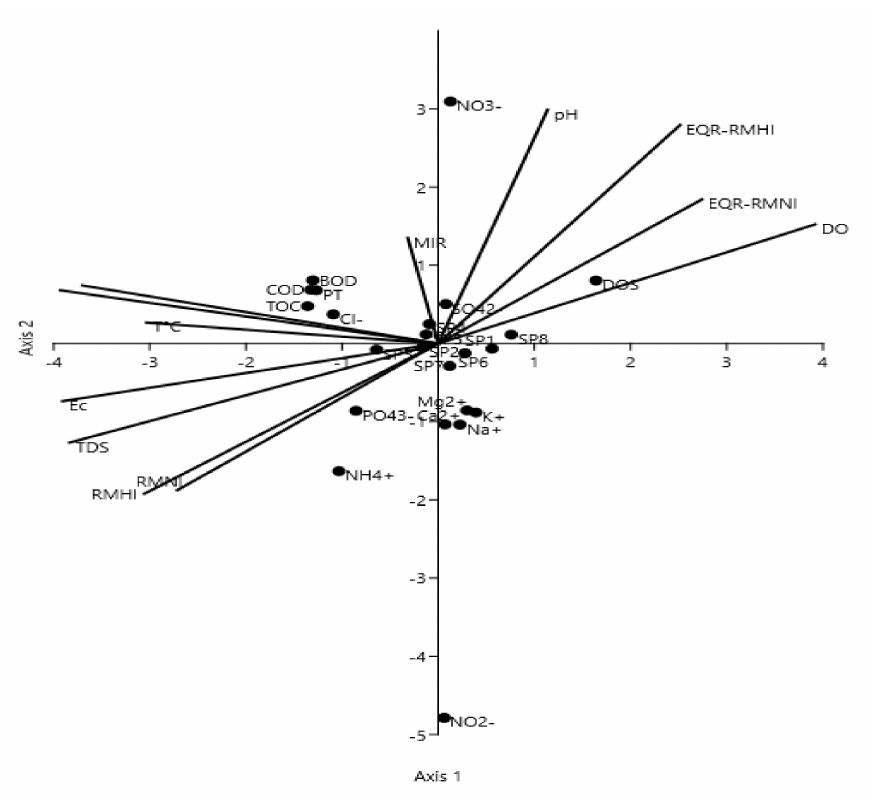
Figure 3. CCA (canonical correspondence analysis) plot showing the relationships between plant density, value indices, and physicochemical